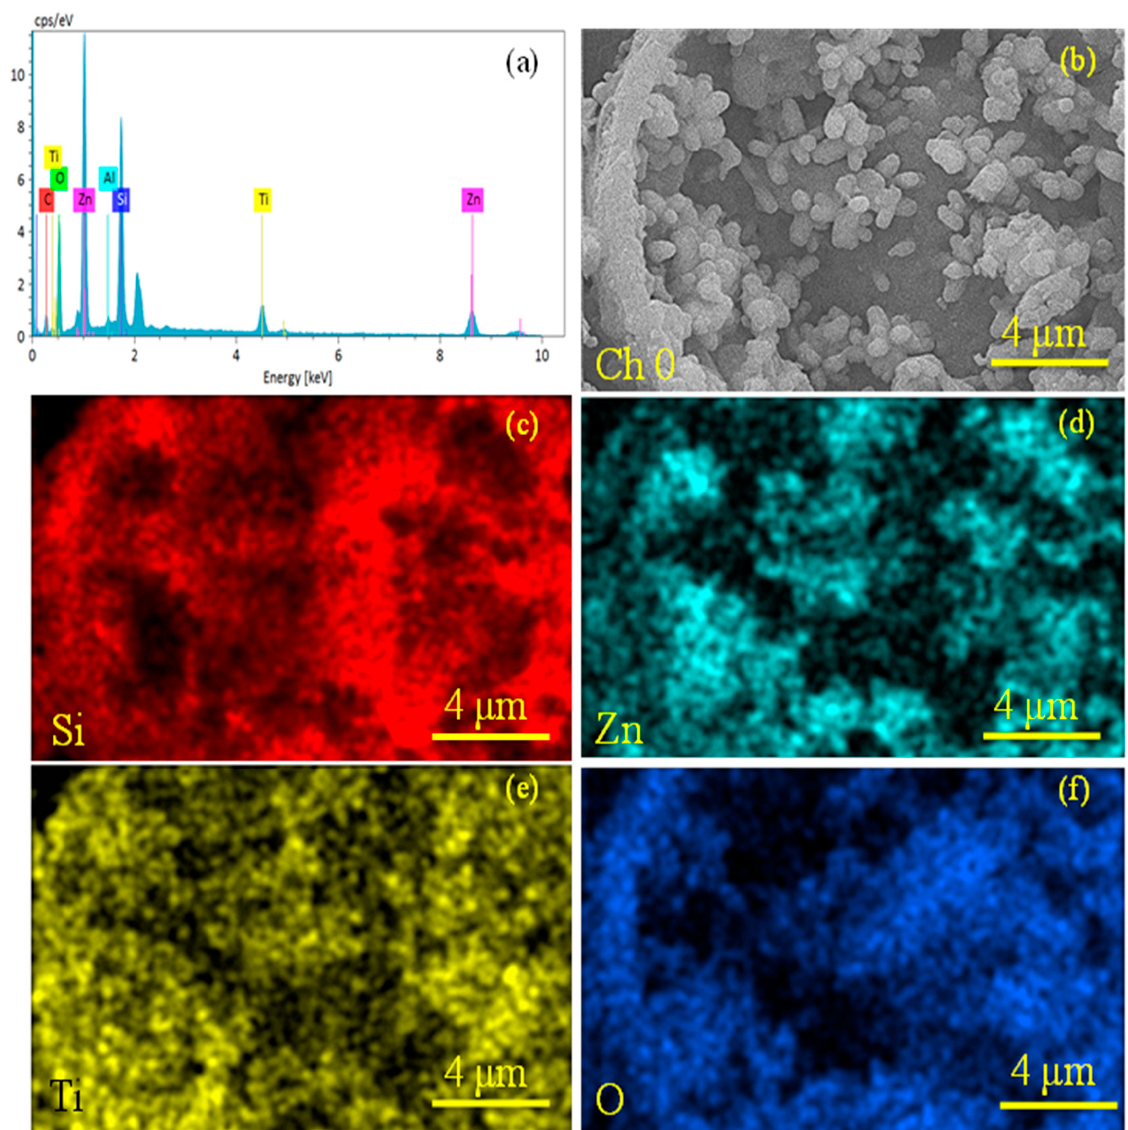
Figure 3. EDS spectrum and corresponding elemental maps of TiO 2 (30%)/ZnO(10%)/diatomite: ( a ) survey spectrum, ( b ) SEM image, ( c ) Si map, ( d ) Zn map, ( e ) Ti map, and ( f ) O map.